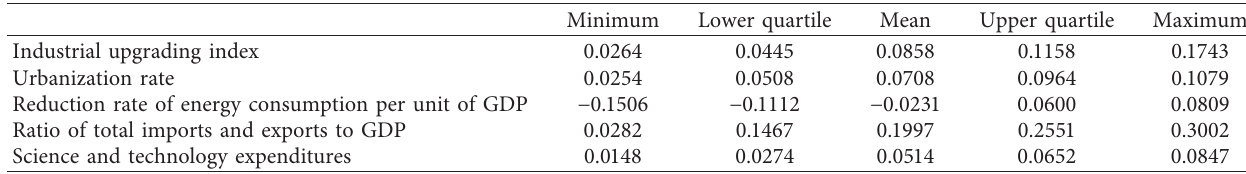
Table 6: Results of the GWR